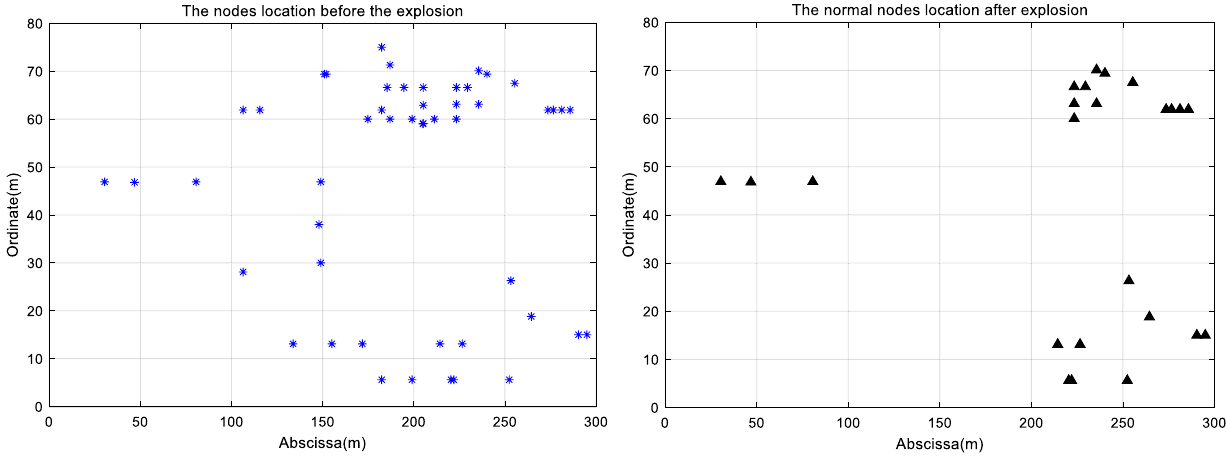
Fig. 5 The normal node distribution of ship network before and after explosion